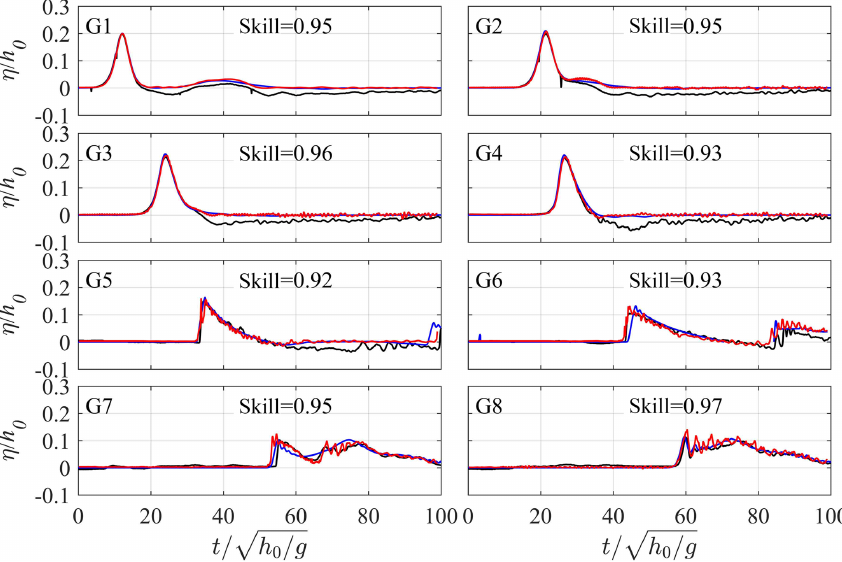
Figure 11. Time series of dimensionless free-surface elevations ( η/h 0 ) at different cross-shore sampling locations (G1–G8) for Scenario 4. Red lines – present simulations; blue lines – simulations from Yao et al. (2008); black lines – measurements from Yao et al. (2008); skill values are for the present